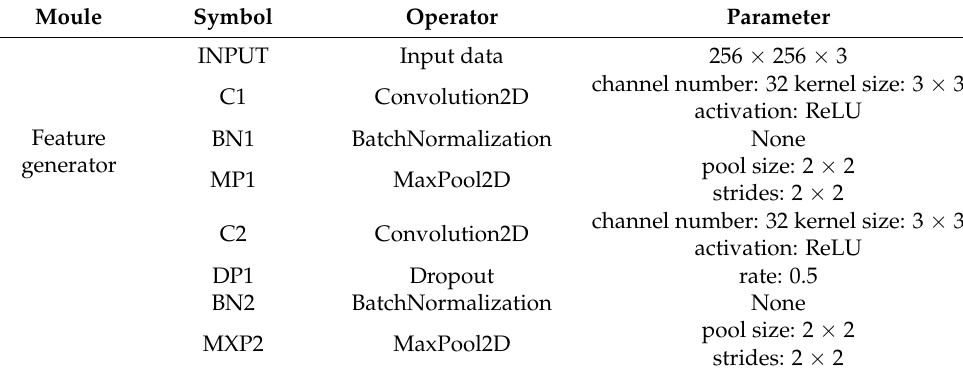
Table 1. Network structural parameters of